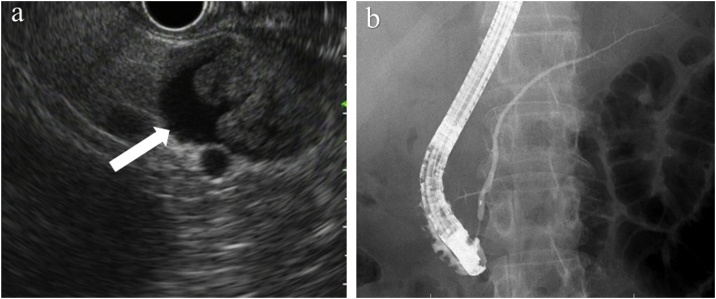
Endoscopic imaging: A. Endoscopic ultrasonography (EUS) showed a cyst with multiple high-echoic lesions in the pancreatic tail (arrow). B. Endoscopic retrograde cholangiopancreatographic image showed a normal main pancreatic duct and no communication between the main pancreatic duct and the cystic lesion.